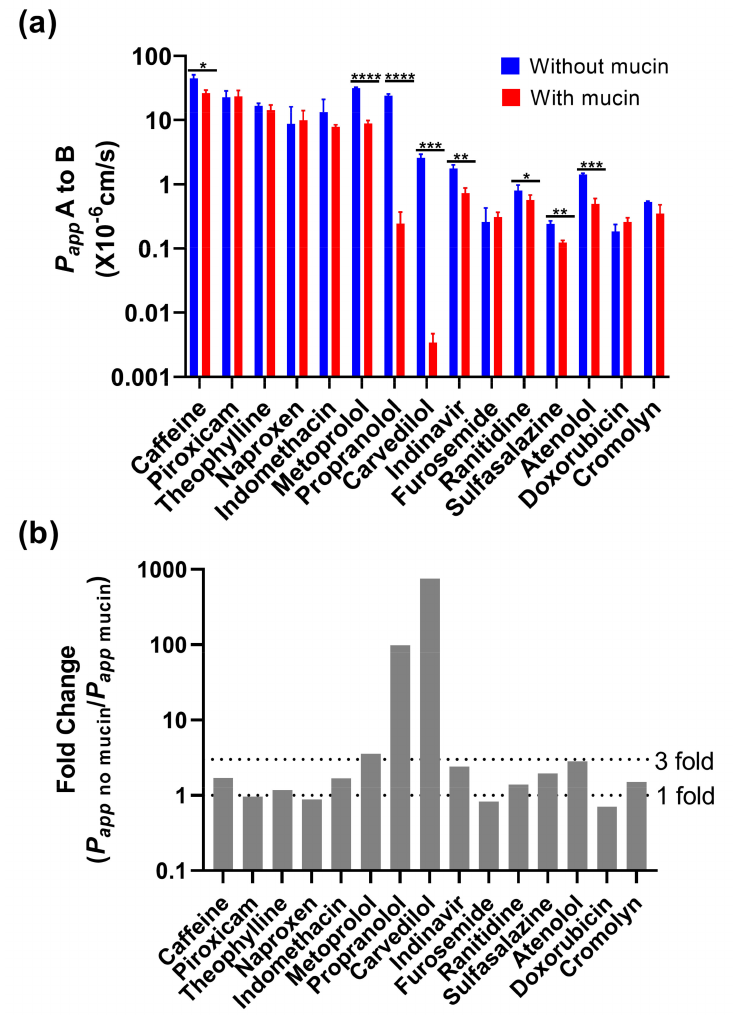
Figure 3. Permeability of 15 reference drugs in the presence or absence of 100 mg/mL of mucin in the Caco-2 permeability assay. ( a ) The drugs were measured in HBSS pH 6.5 with absence and presence of mucin; ( b ) Based on these results, the fold change was calculated by dividing the mucin-free P app value with the mucin-dependent P app value. Statistical result was calculated with a paired t -test, with significance defined at p ≤ 0.05 (*), p ≤ 0.01 (**), p ≤ 0.001 (***), p ≤ 0.0001